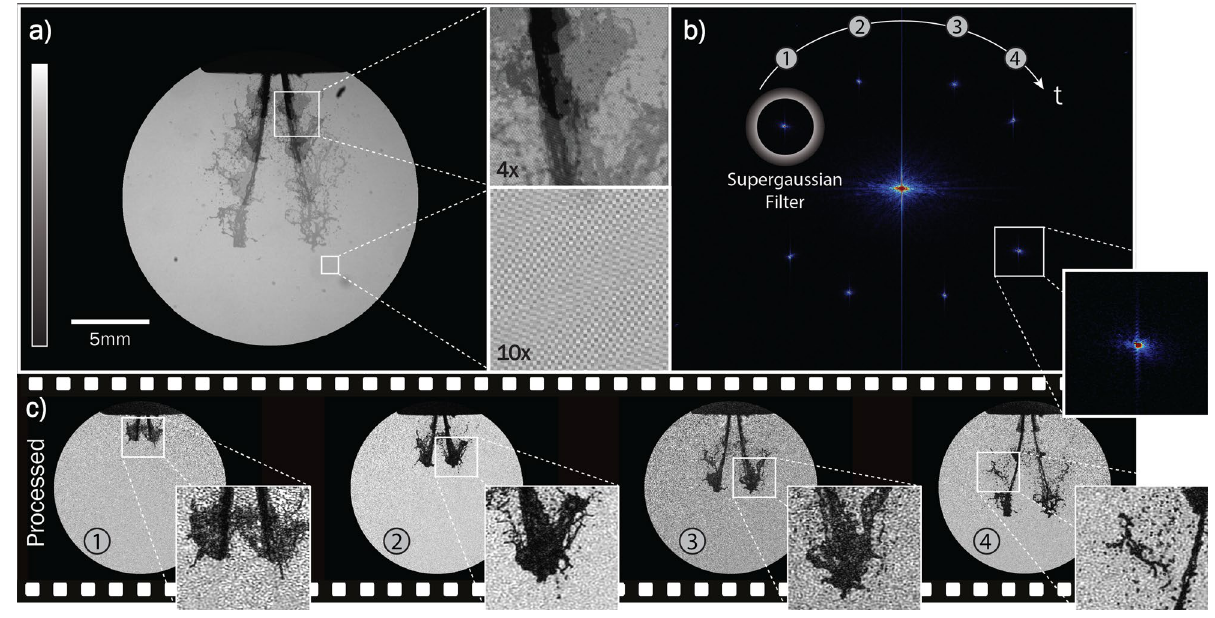
Figure 3. The extraction process of a 20 kHz image series. ( a ) The single exposure (raw) image with the four uniquely modulated pulses summed onto the camera sensor. The crosshatch pattern of the superimposed modulations is highlighted in the 10 × zoom. ( b ) The Fourier transform of ( a ) where each Fourier cluster holds the image information from a single pulse. ( c ) The extracted, background-corrected image series, where the zoom-ins highlight the visibility of fine Fig. 3a show the resulting crosshatch pattern of the overlapping modulated structures (10 × zoom) and the various grayscale shadows of the spray at different times as the pulse train illuminates it (4 × zoom). It can be seen that the dynamic range of the sensor has been divided among the four illuminating pulses, resulting in gradually lighter shadows in the pixel positions the spray covers as it evolves. Here, in the spatial domain, the image information for the individual events overlap and cannot be accessed. However, the angle and frequency of the Ronchi gratings have been chosen such that their corresponding Fourier clusters are placed as far away from adjacent clusters and